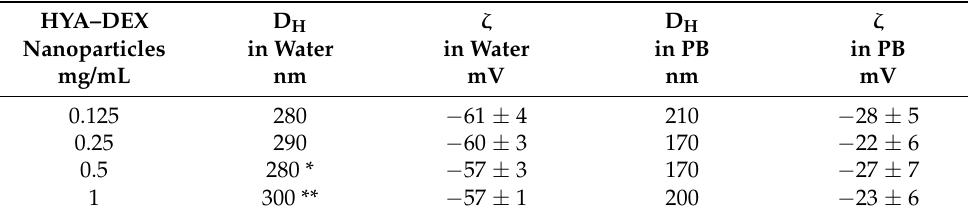
Table 2. Hydrodynamic diameter (D H ) measured by DLS and Z- potential ( ζ ) at different concen- trations of HYA–DEX nanoparticles resuspended in water or phosphate buffer (PB). Polydispersity index is around 0.3–0.4. Results in water are viscosity corrected, * 1.2 cps, ** 2.5 cps.